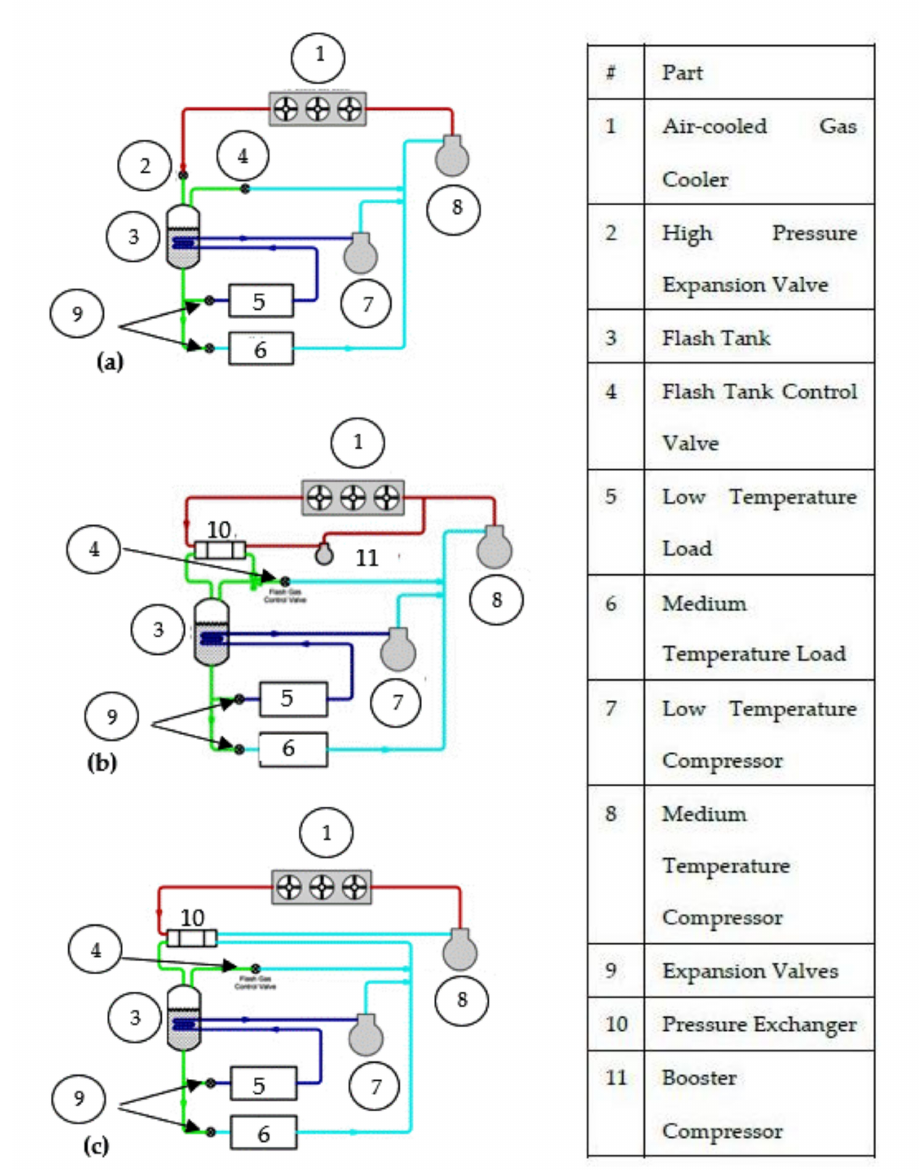
Figure 1. Trans-critical CO 2 booster refrigeration system configurations: ( a ) Basic cycle without pressure exchanger, ( b ) Cycle with pressure exchanger on flash gas bypass, and ( c ) Cycle with pressure exchanger on medium-temperature compressor